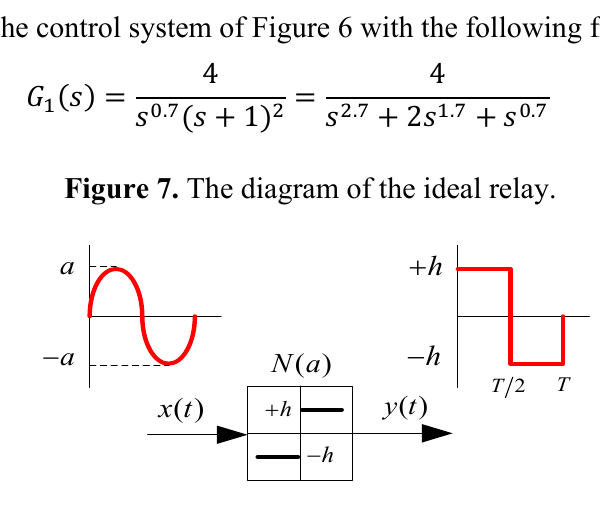
Figure 8. The diagram of the relay with